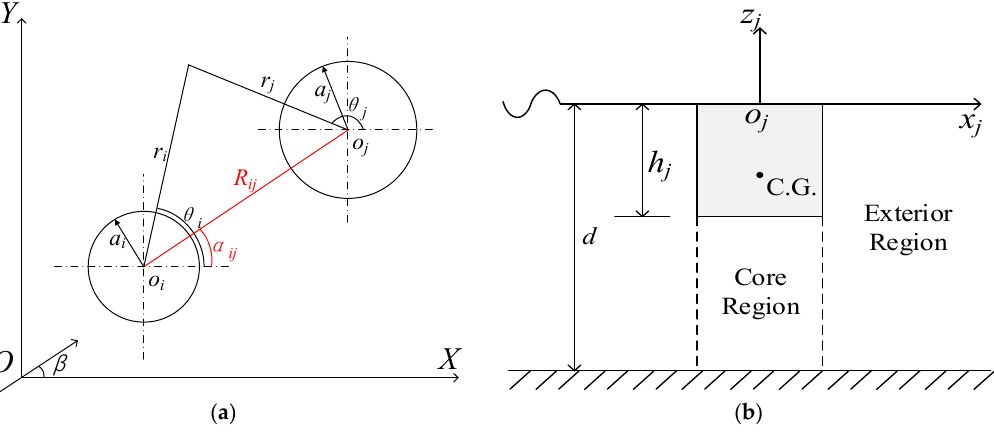
Figure 2. ( a ) The coordinate systems for WEC array; ( b ) fluid domain division.